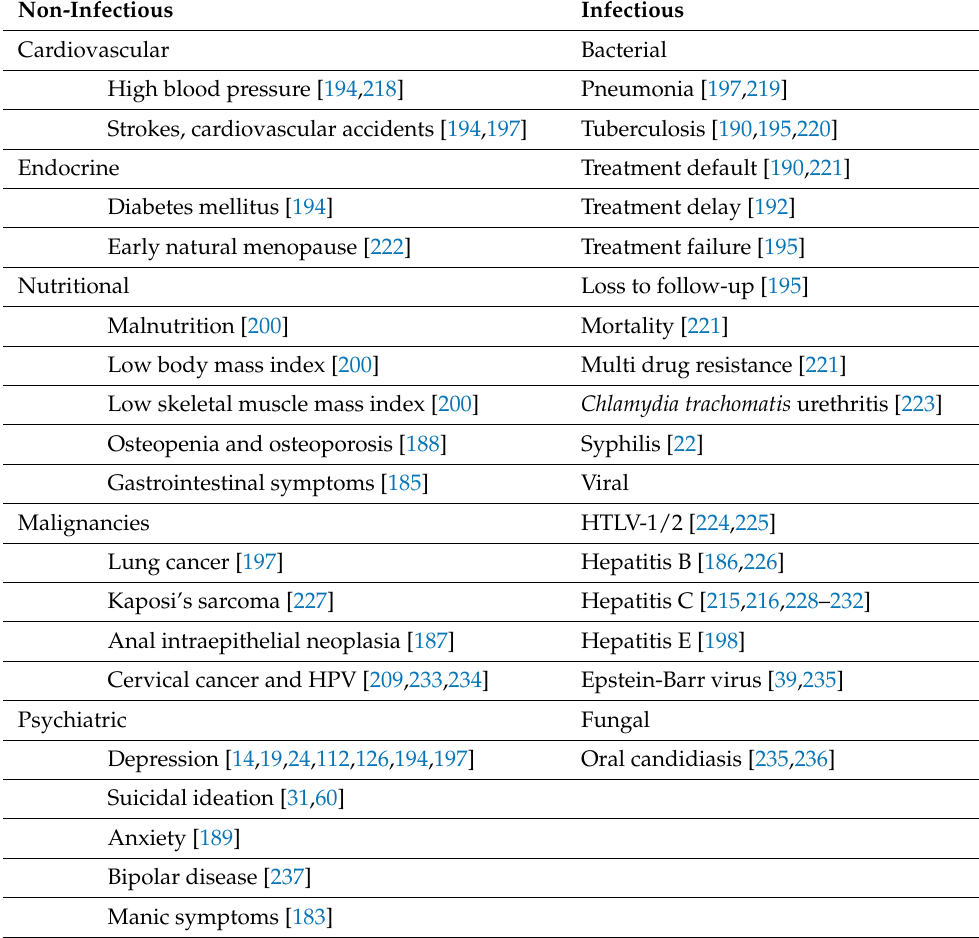
Table 4. Comorbidities associated with substance use among people living with